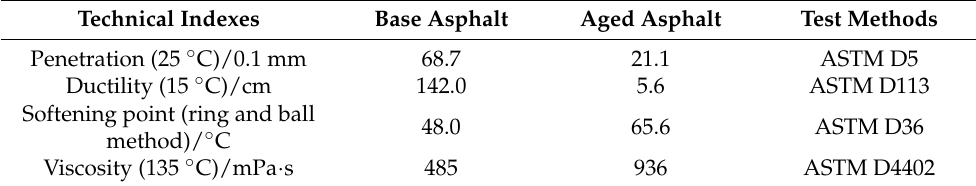
Table 2. Technical indexes of substrate asphalt and aged